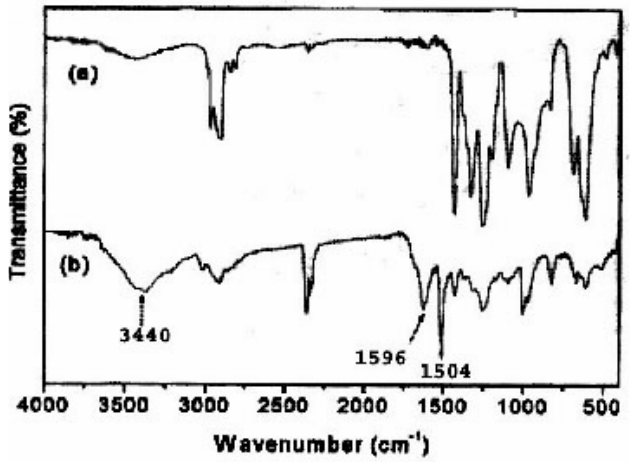
Figure 2. FT-IR spectra of (a) pure PVC and (b) PVC-Polyaniline